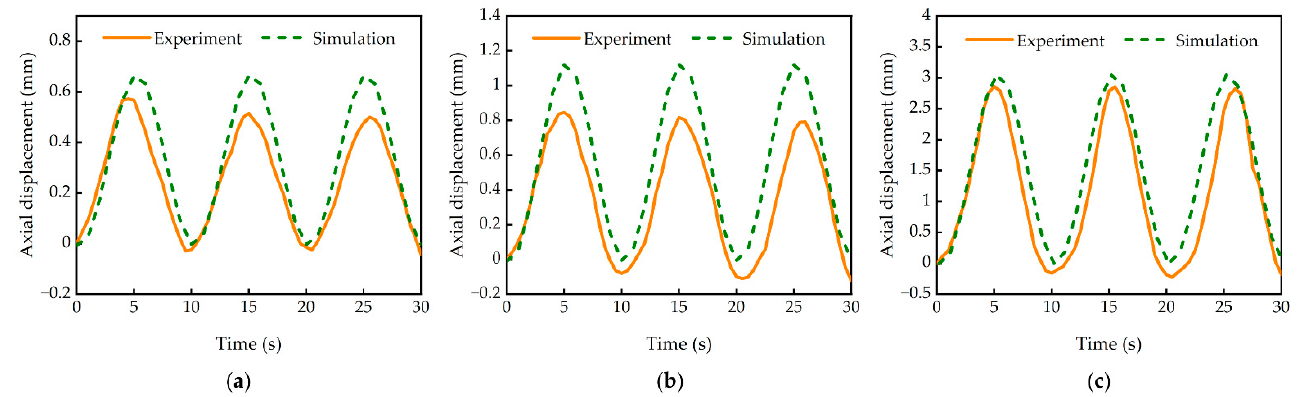
Figure 14. Experimental and simulated data of axial displacement of the helical IPMC actuator under sinusoidal signals with different amplitudes: ( a ) 1 V, 0.1 Hz; ( b ) 2 V, 0.1 Hz; ( c ) 3 V, 0.1 Hz.